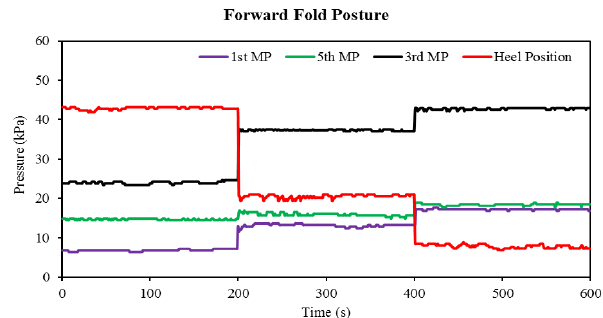
Figure 9. The elapsed time of the pressure change in the Flexi force sensor during the forward folded position.